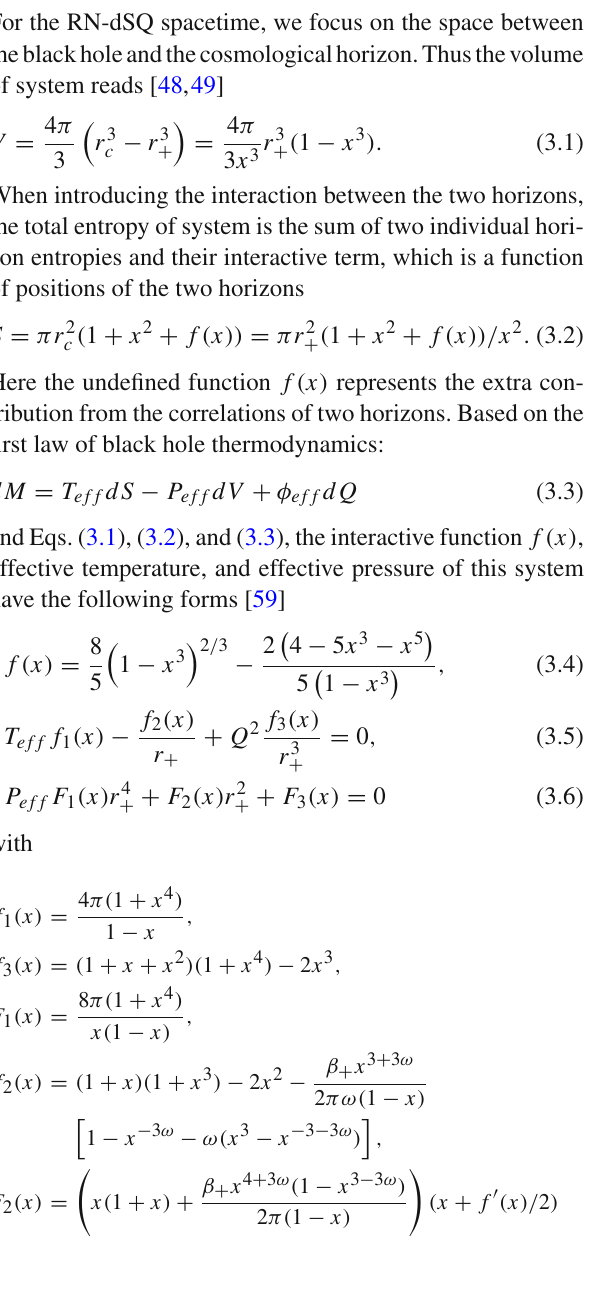
Fig. 4 Curves of x min − l 2 with Q = 1. a The black solid line stands for ω = − 1 / 2, the blue solid line is for ω = − 2 / 3, and the red solid line is for ω = − 5 / 6. b the red dotted line stands for β + = 0 . 0001, the green solid line is for β + = 0 . 0005, and the black dashed line is for β + = 0 .